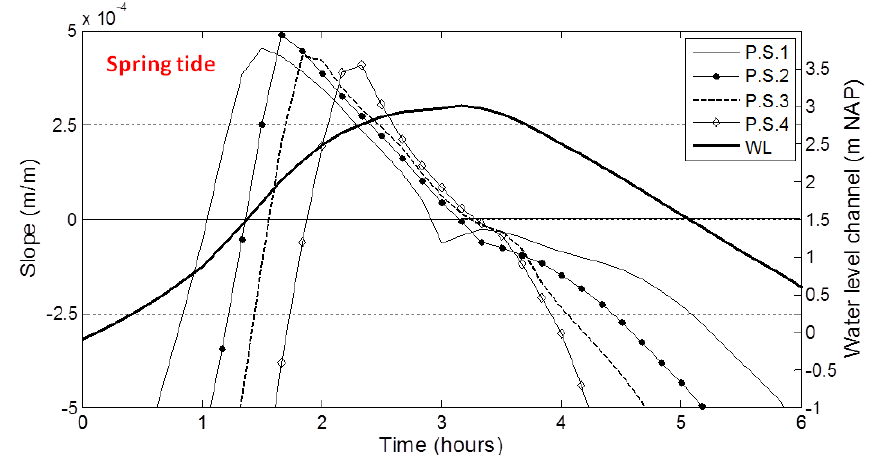
Figure 6. Water surface slopes for scenarios with different schematic wetland elevations (P.S.1, P.S.2, P.S.3 and P.S.4) for a spring tide between middle of the main estuarine channel and the wetland edge (distance was about 1000m). Positive slopes occur when the water floods from the main channel onto the wetland and negative slopes when the water drains again from the wetland towards the main channel. As a reference, the water level fluctuation in the main estuarine channel (thick black line) is given with values on the right y